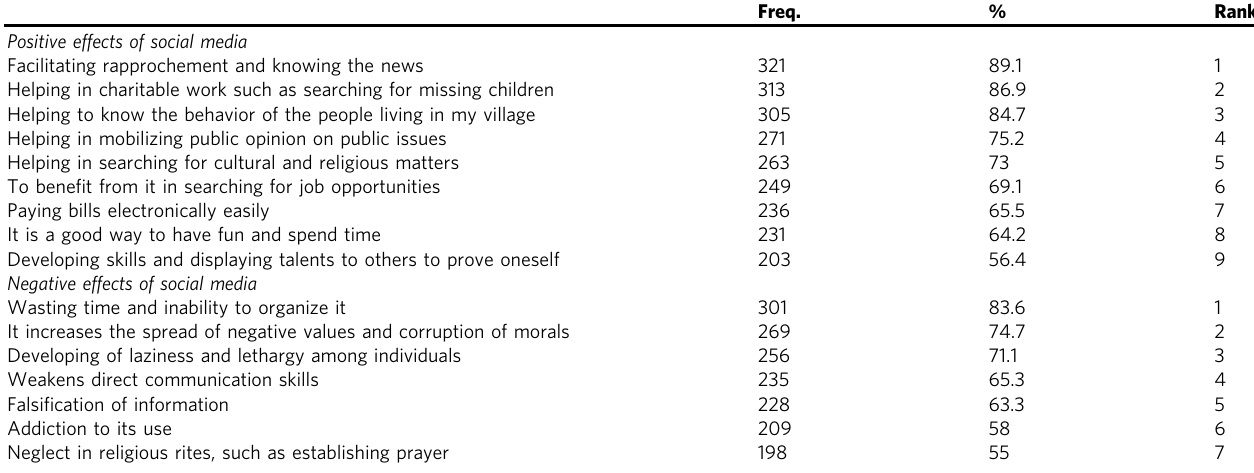
Table 12 The positive and negative effects of social media from the respondents ’ point of